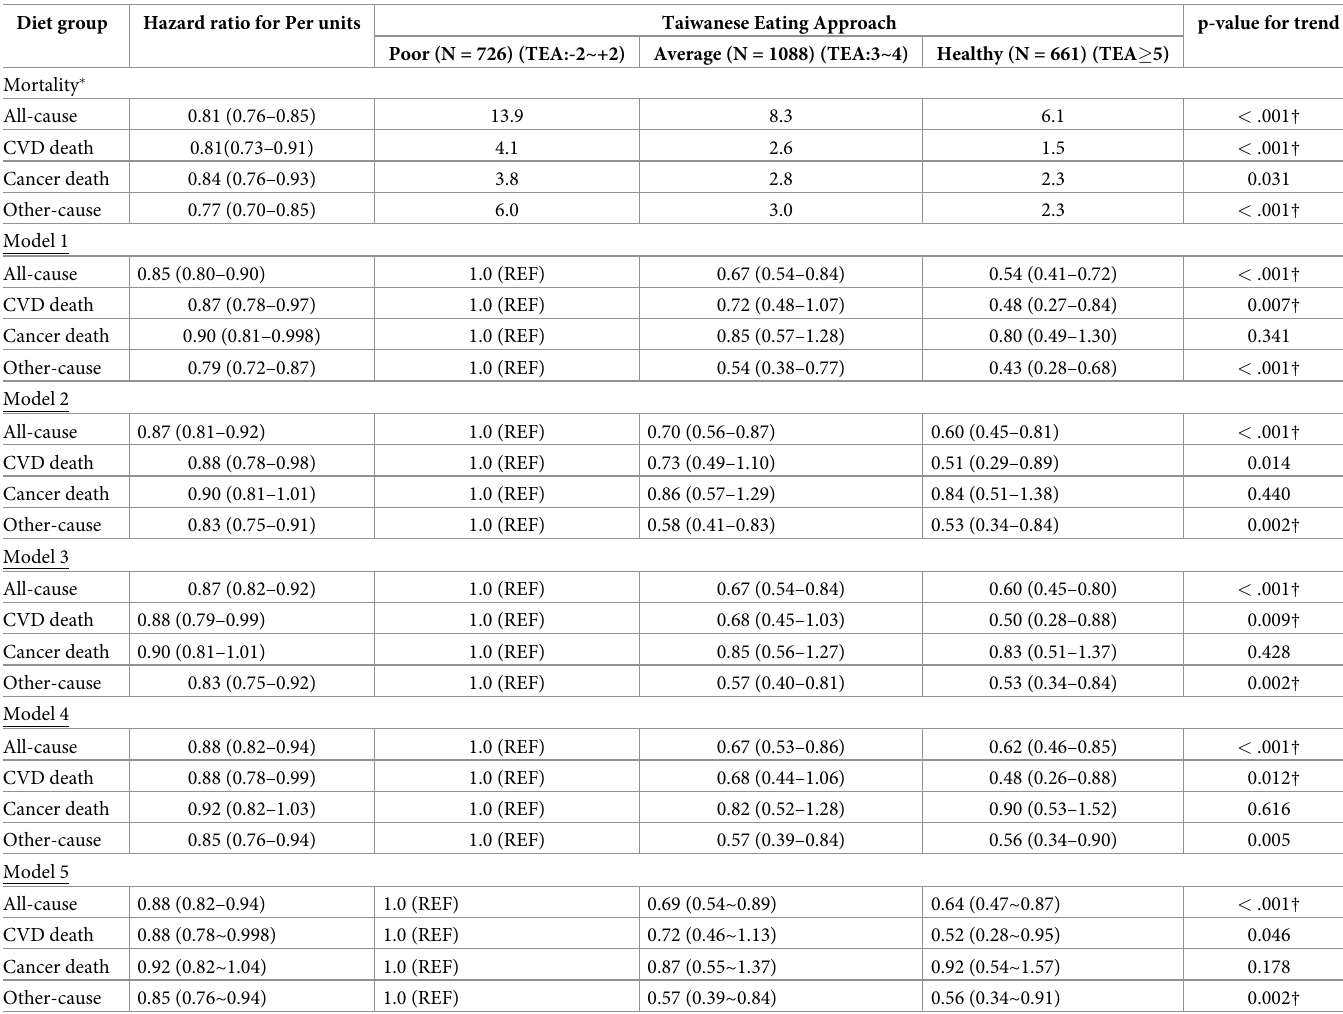
Table 3. The association between the Taiwanese Eating Approach score and mortality (all causes, cancer, and cardiovascular mortality) among young adults (n = 2475). Model 1: adjusted for age and sex. Model 2: adjusted for age, sex, exercise, smoking, drinking, and education. Model 3: adjusted for age, sex, exercise, smoking, drinking, education, obesity, and number of self-reported diseases. Model 4: adjusted for age, sex, exercise, smoking, drinking, education, obesity, number of self-reported diseases, systolic BP, diastolic BP, triglycerides, HDL-C, LDL-C, sugar intake (times/week), and belt-nuts (times/week). Model 5: all independent variables included in model 4 among those without a history of cancer at baseline (n =